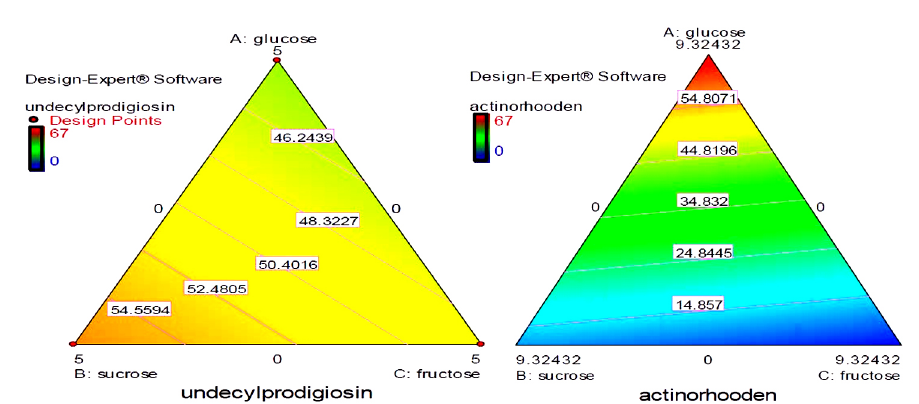
Fig.7. Quadratic contour area ternary plots of three carbon sources and their effect on the production of actinorhodin and undecylprodigiosin by Streptomyces coelicolor